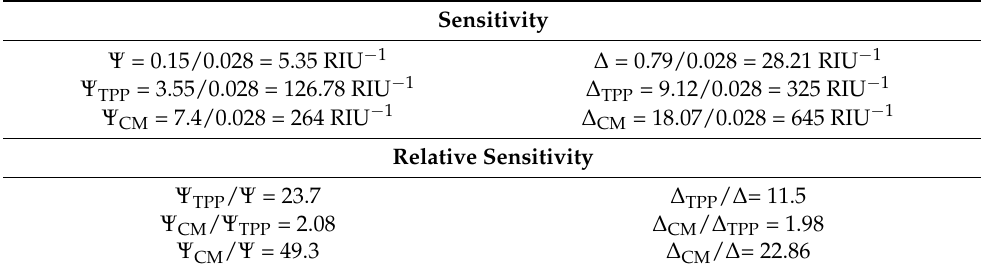
Table 1. Sensitivity and relative sensitivity of ellipsometric parameters changes to refractive index unit